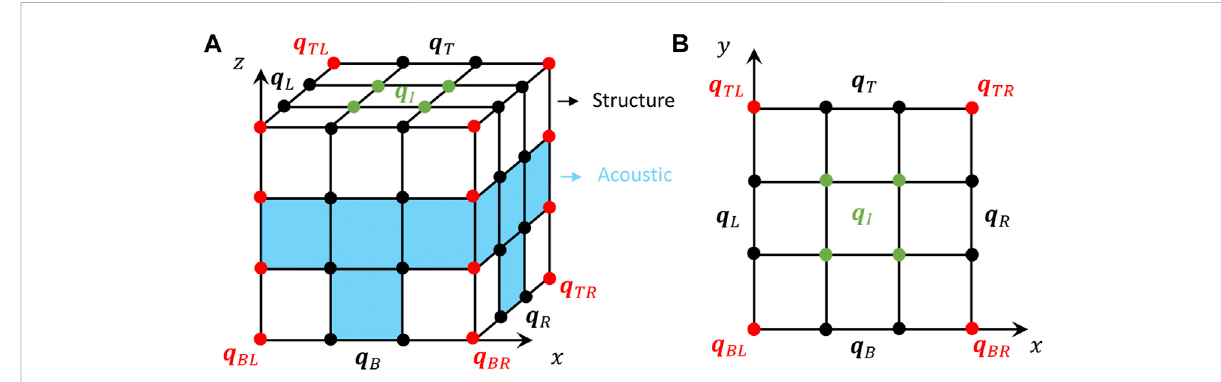
FIGURE 1 Schematic visualization of the node groups for a 2D periodic vibro-acoustic UC: (A) three-dimensional view, (B) top